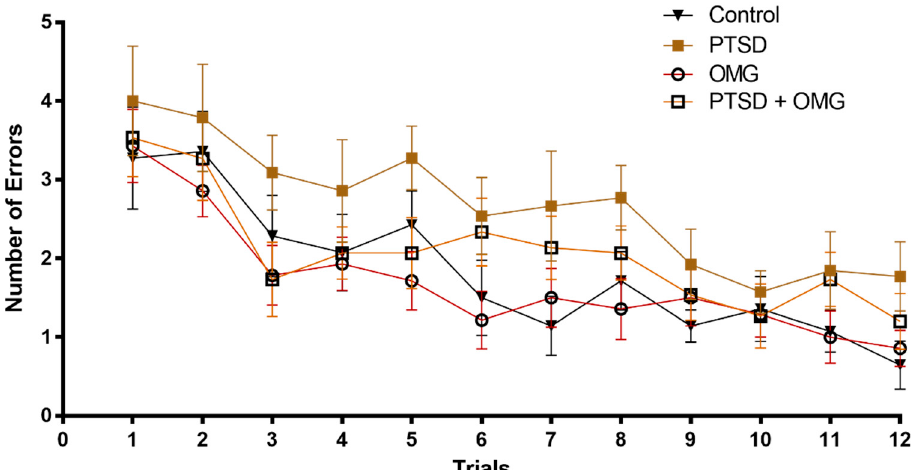
Figure 1. Omega-3 and/or single-prolonged stress (SPS) model of post-traumatic stress disorder (PTSD) did not affect learning performance. The number of errors made by each animal decreased with continued learning trials (1 through 12) without significant differences among control, PTSD, omega-3 treated animals (OMG), and post-traumatic stress disorder (PTSD) treated with OMG (PTSD + OMG) groups. Each point is the mean ± standard error of the mean (SEM) of 15 rats.